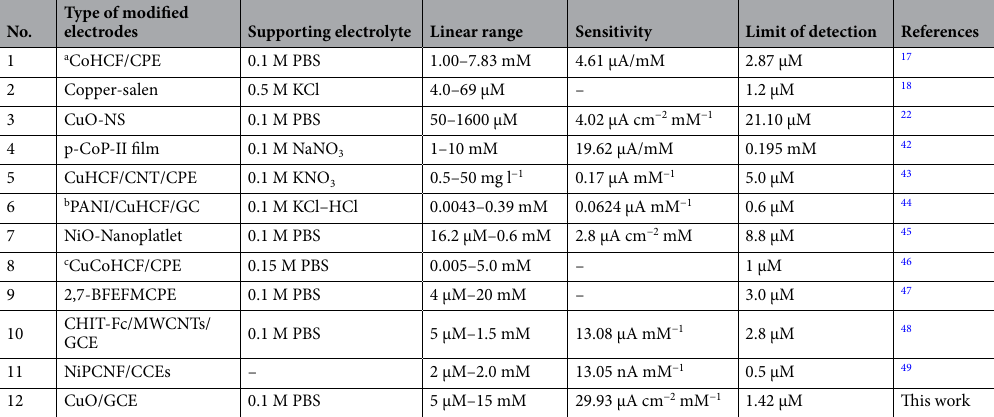
Table 1. Displays the electrochemical sensor parameter of different electrochemical sensors for the determination of SO 3 2− . a Cobalt hexacyanoferrate. b Polyaniline-coated copper hexacyanoferrate. c Copper- cobalt